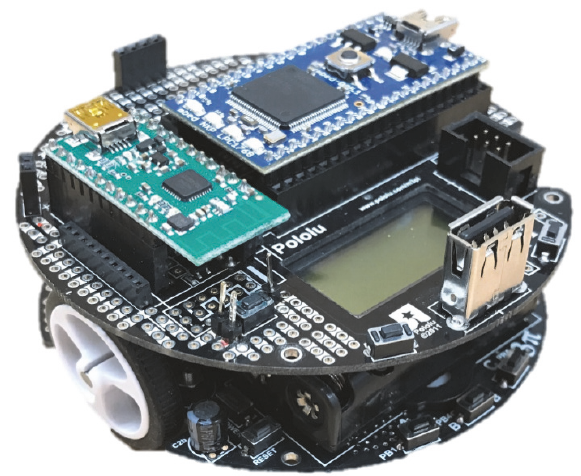
Figure 1: The m3pi hobbyist robotic platform, which was the foundation of the SAR developed for this study.